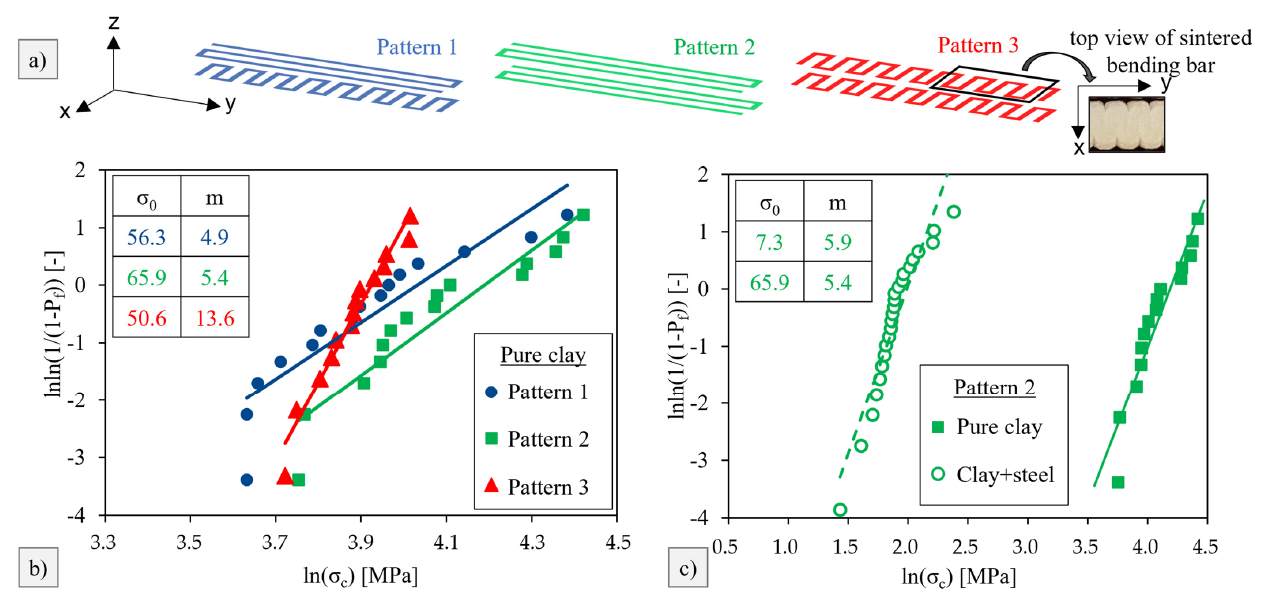
Figure 6. ( a ) Printing patterns 1, 2, and 3 of the different tested groups of bending bars. ( b ) Weibull plot of pure clay printed in the different printing patterns. ( c ) Weibull plot of pure clay and clay with 17.5 wt.% AISI 630 particles, both printed in pattern 2.